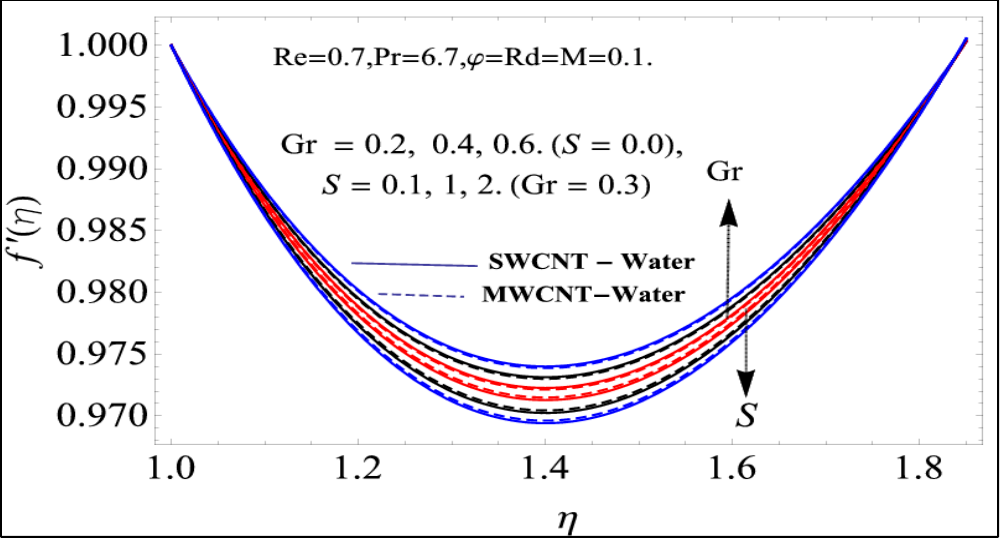
Figure 5. Impact of the Gr & S on the velocity field.